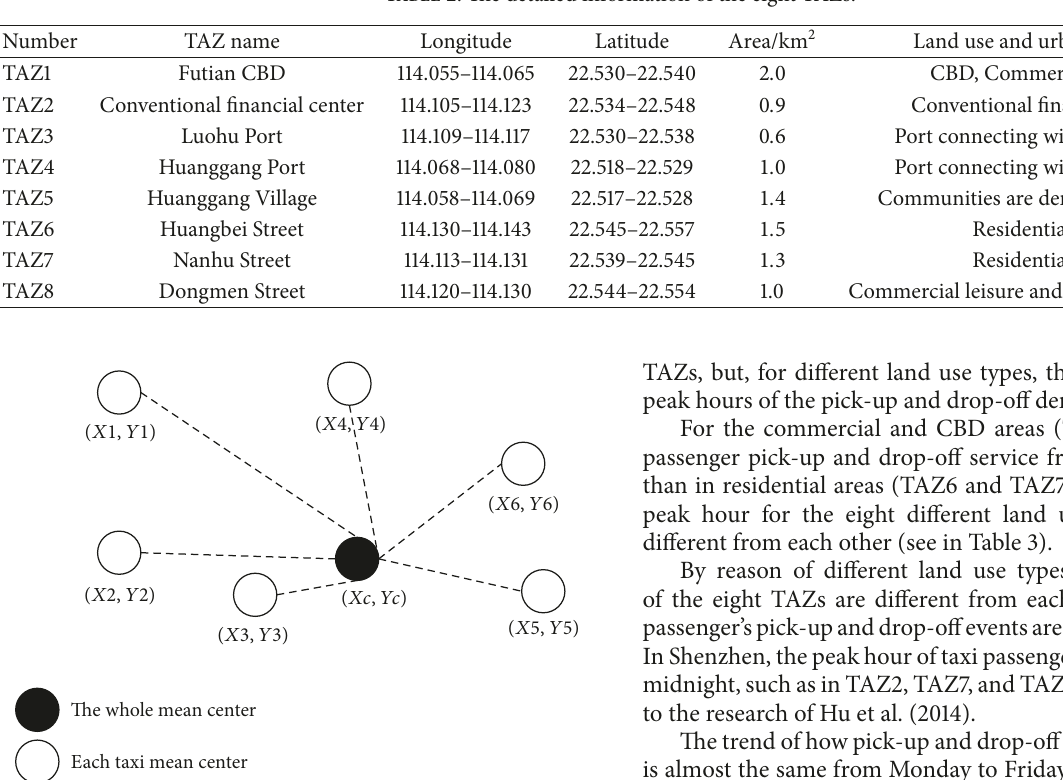
Table 2: The detailed information of the eight TAZs.